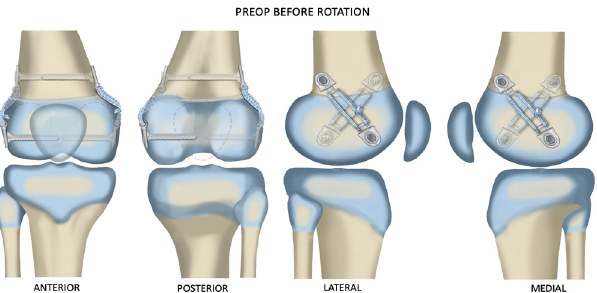
Figure 3. One implant was placed medially and the other laterally inclined, as shown, so that the crossing angle was as close to 90° as possible. Illustrations copyrighted to the Paley Foundation; reprinted with permission.